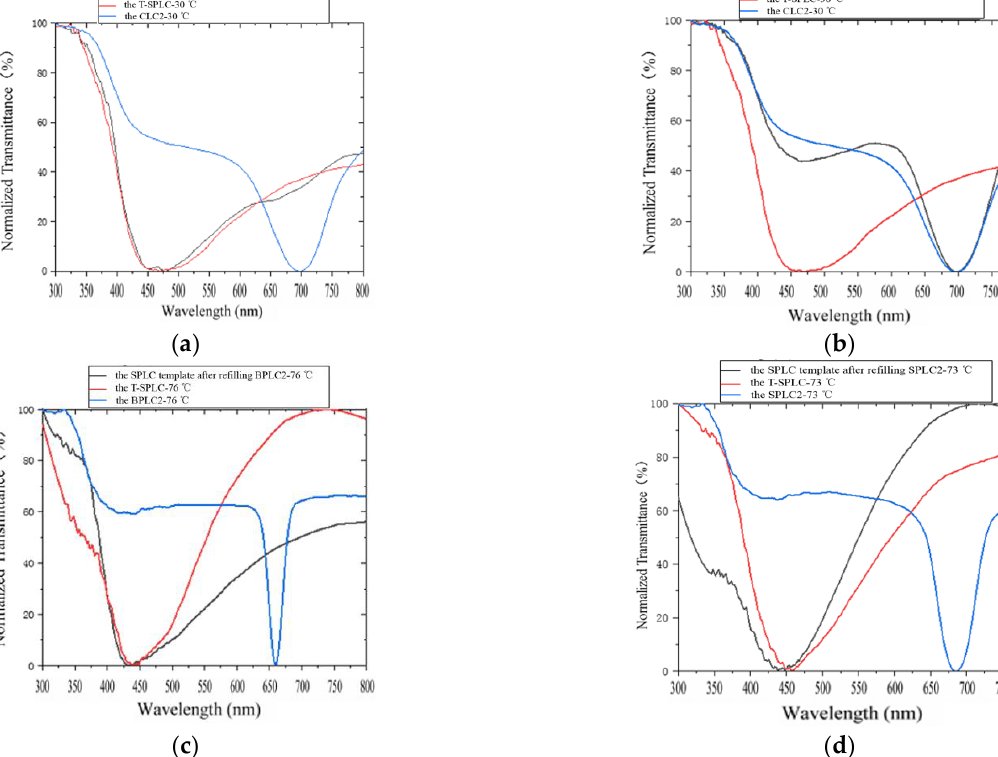
Figure 14. The reflection spectra of ( a ) CLC2, T-SPLC, and the SPLC template after refilling CLC2; ( b ) CLC2, T-SPLC, and the CLC2 were directly refilled into the SPLC template at 30 °C; ( c ) BPLC2, T-SPLC, and the SPLC template after refilling BPLC2; ( d ) SPLC2, T-SPLC, and the SPLC template after refilling SPLC2.